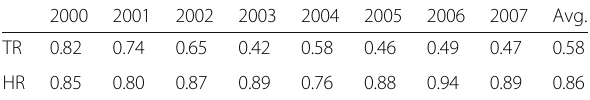
Table 2 The statistical indices of model performance of flood extent true ratio (TR) and hit ratio (HR)